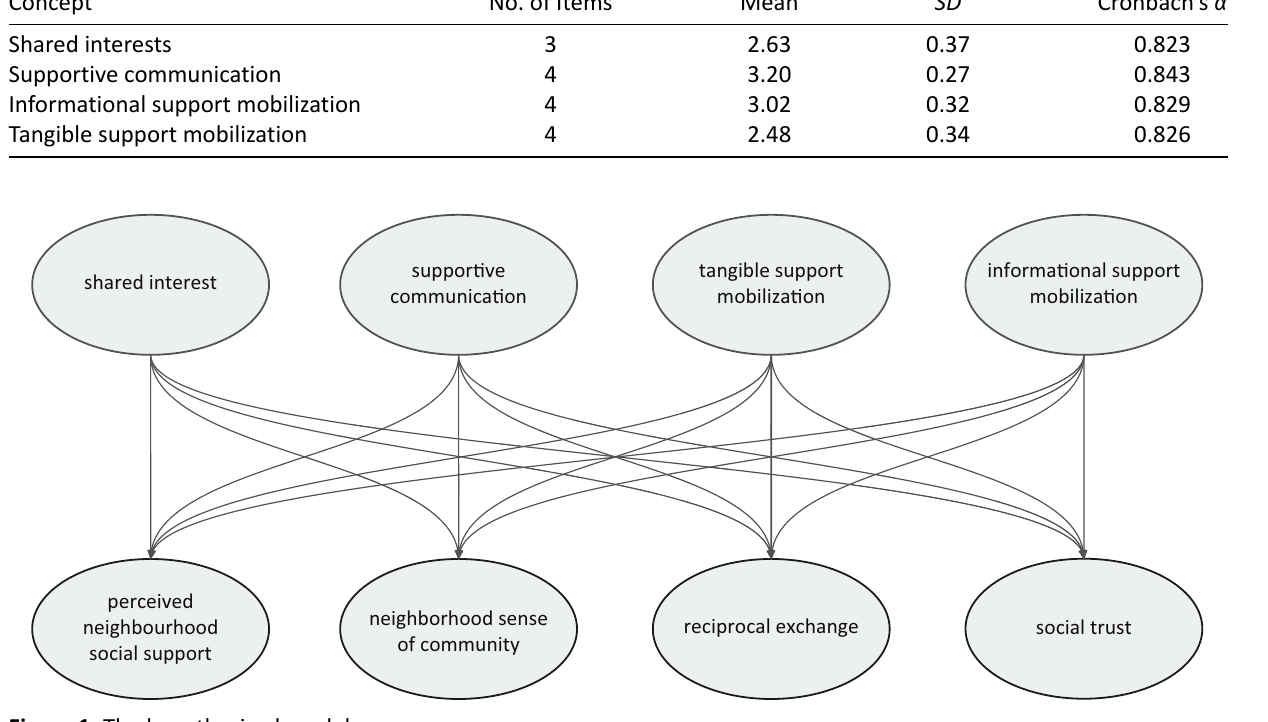
Figure 1. The hypothesized